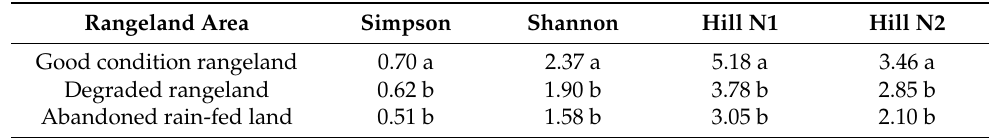
Table 6. Mean values of plant diversity indices in the study rangeland area based on the canopy cover of perennial plant